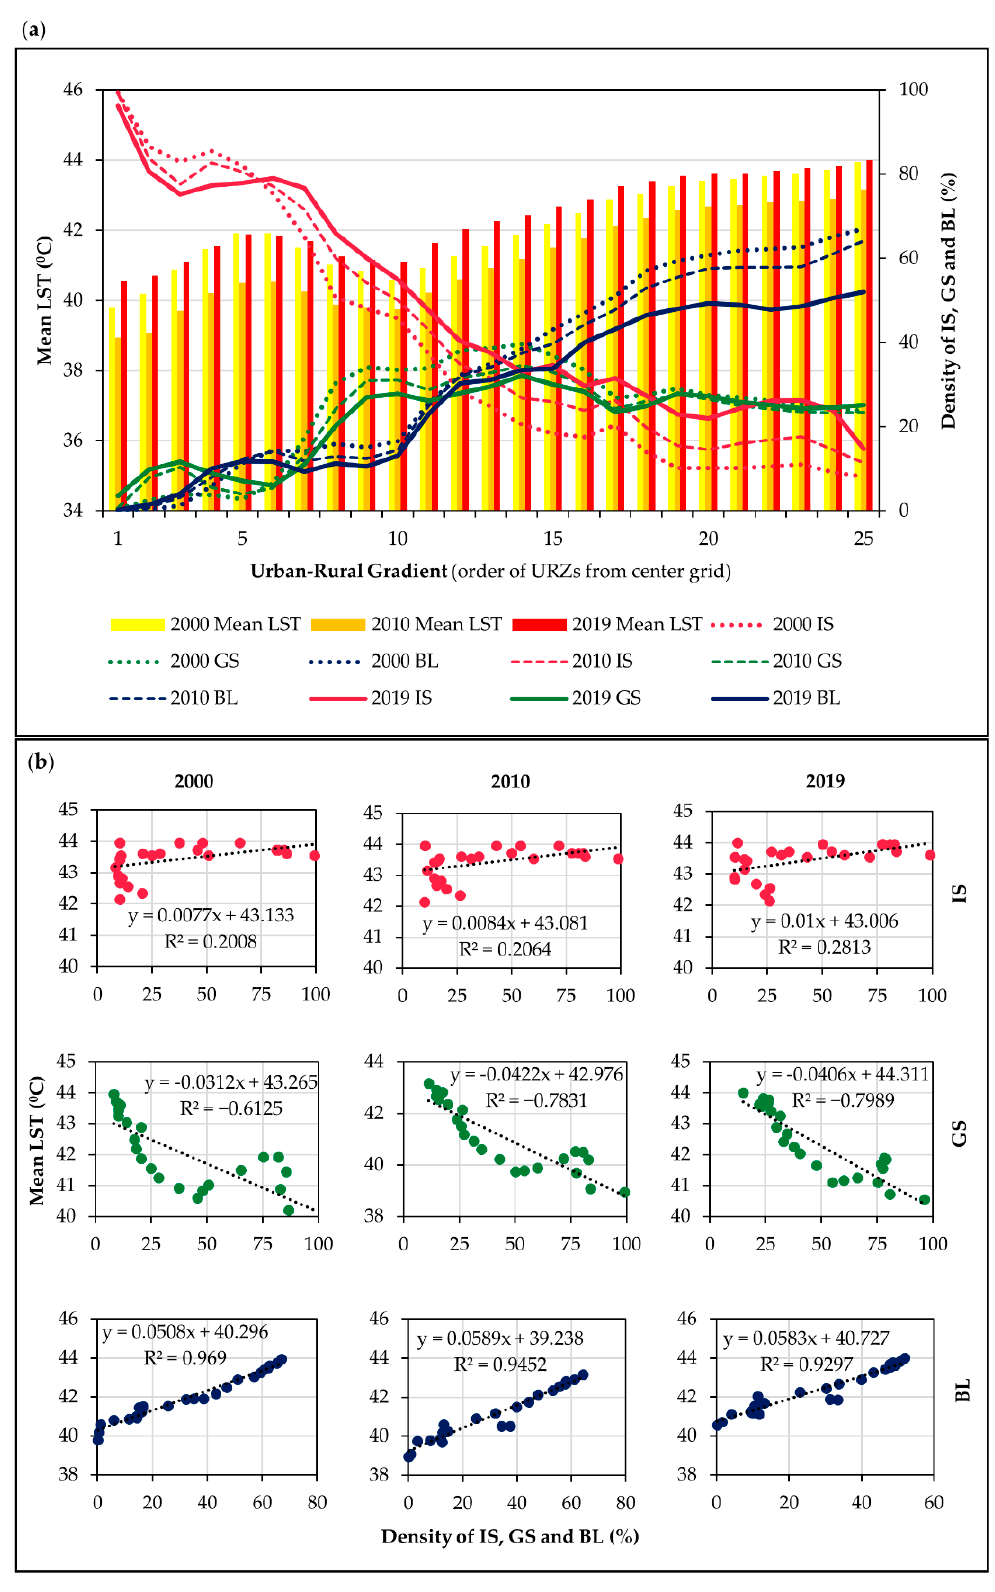
Figure 6. Urban–rural gradient analysis in the daytime: ( a ) mean LST and density of IS, GS, and BL along the urban–rural gradient; and ( b ) statistical relationships between mean LST and density of IS, GS, and BL.